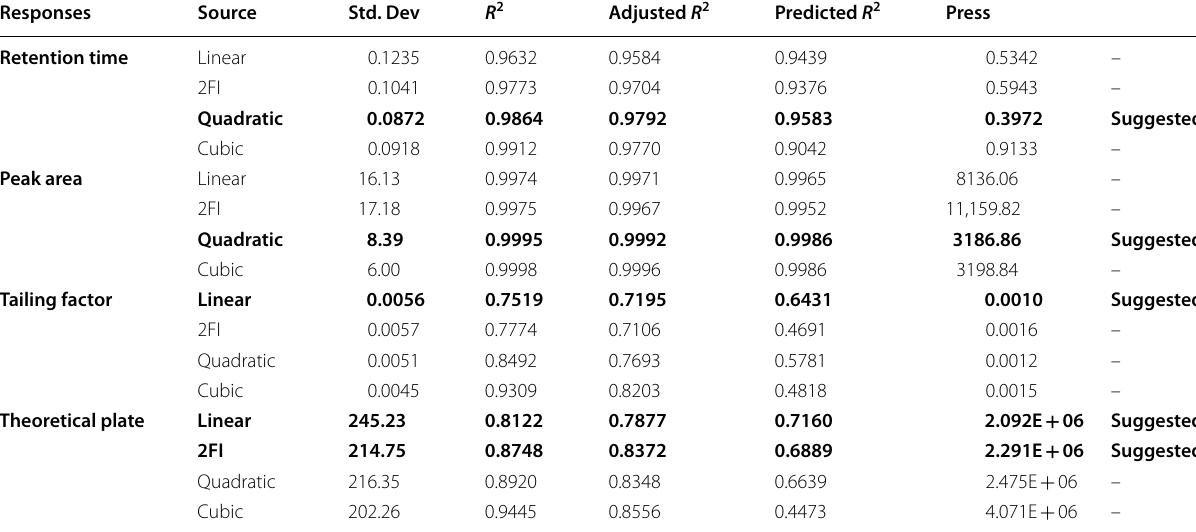
Table 4 Statistics for the model of response